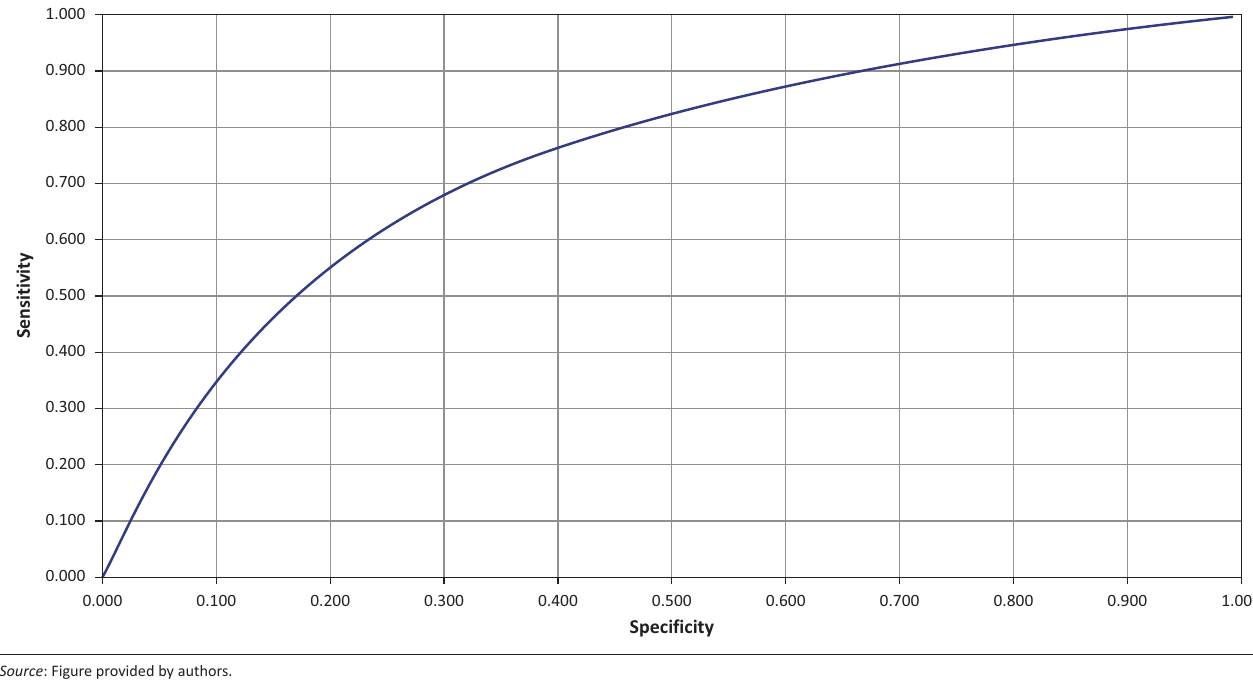
FIGURE 2: The Receiver operating characteristic (ROC)